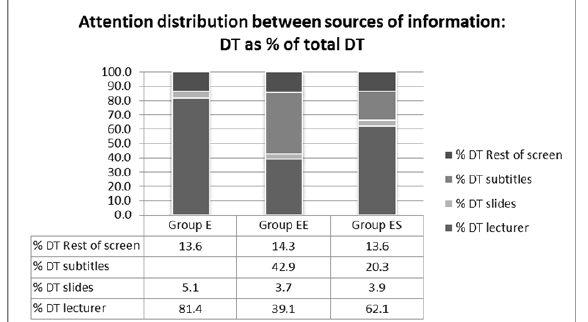
Figure 2. Attention distribution between sources of information: DT as % of total DT For Group EE and Group ES, the difference in the distribution of attention to subtitles, measured as a per- centage of the total dwell time in the subtitle area, reached statistical significance in a Mann-Whitney U-test (U=106.00, z= -3.10, p<0.05).